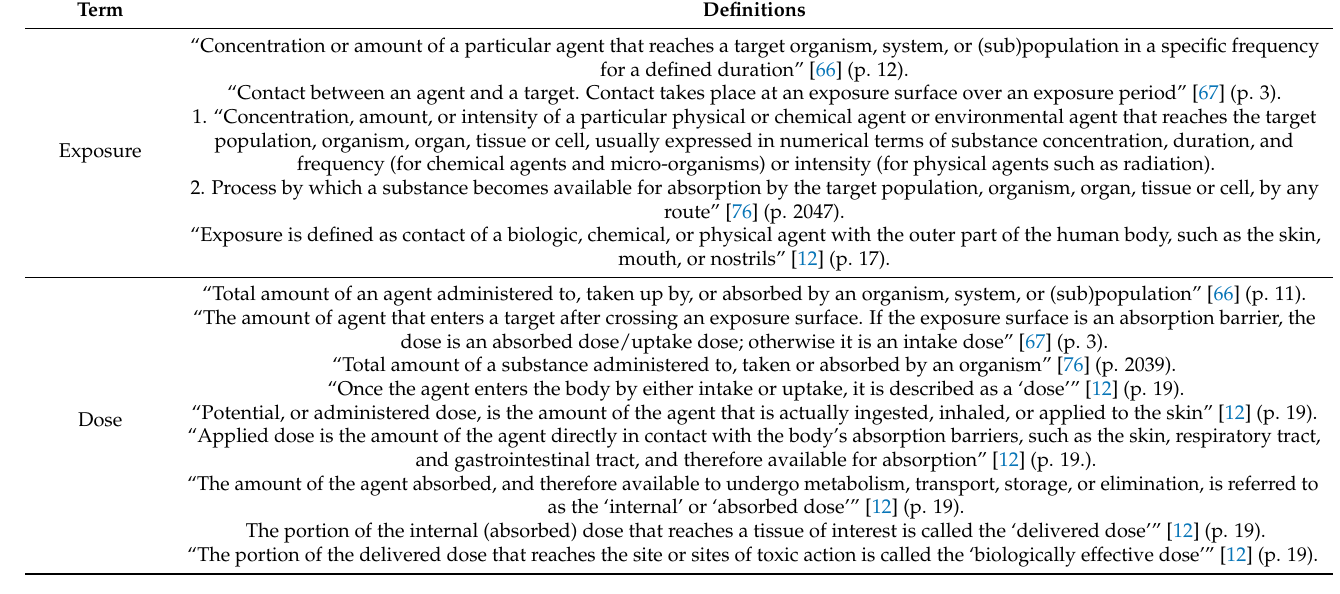
Table 3. Definitions for “exposure” and